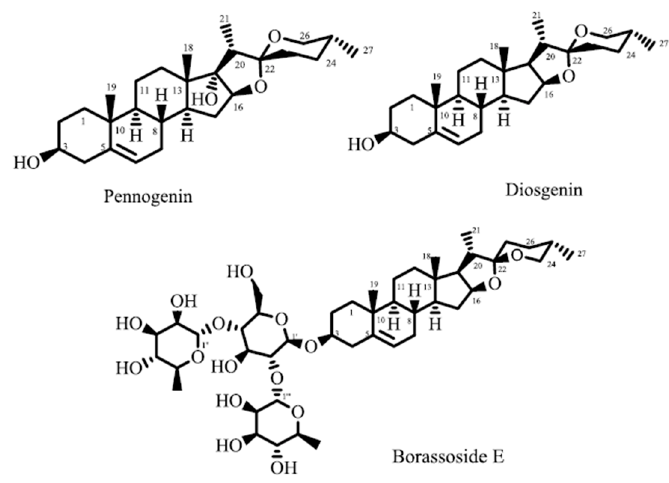
Figure 1 . Compounds of T. govanianum rhizomes exhibiting oxidative burst inhibitory effect. Figure 1. Compounds of T. govanianum rhizomes exhibiting oxidative burst inhibitory